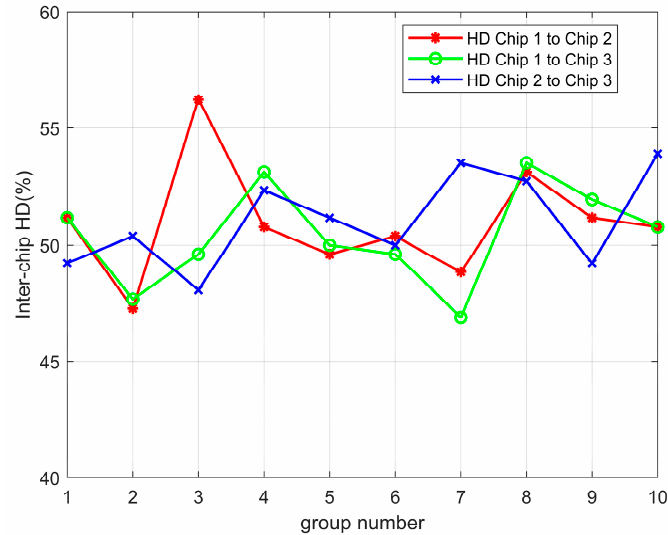
Figure 5. The inter-chip HD in one-layer convolution.